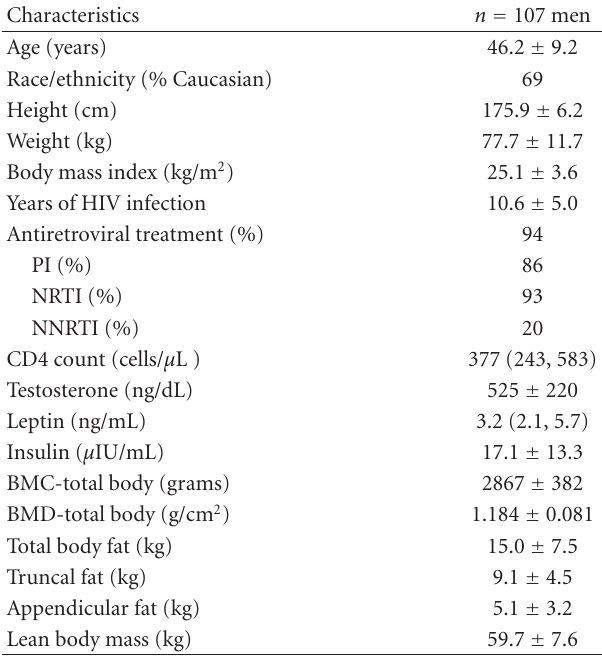
Table 1: Baseline characteristics ∗